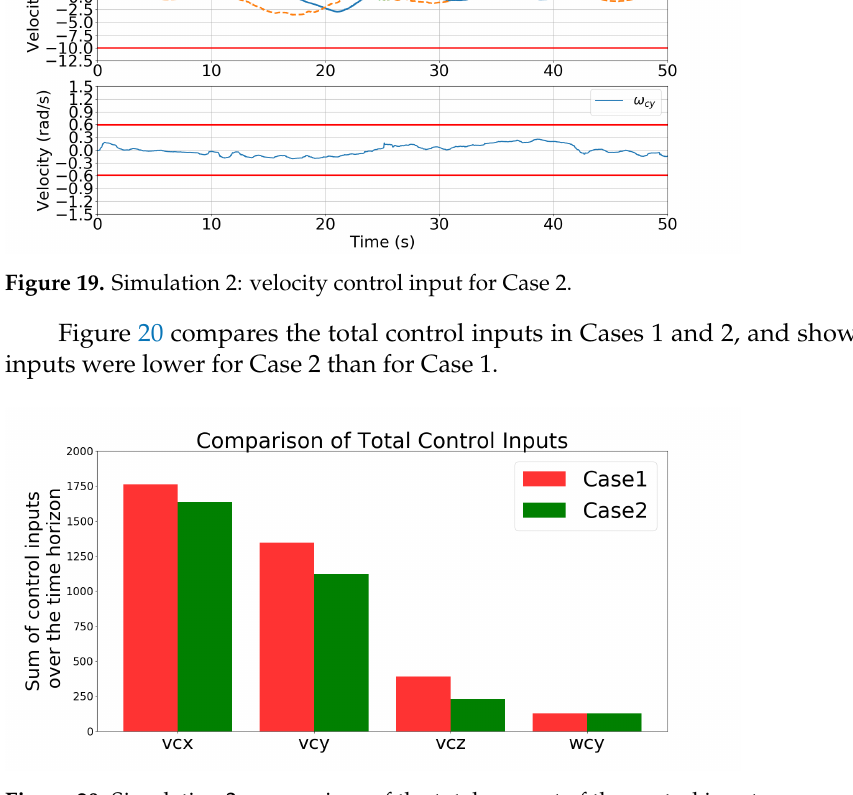
Figure 20. Simulation 2: comparison of the total amount of the control inputs.